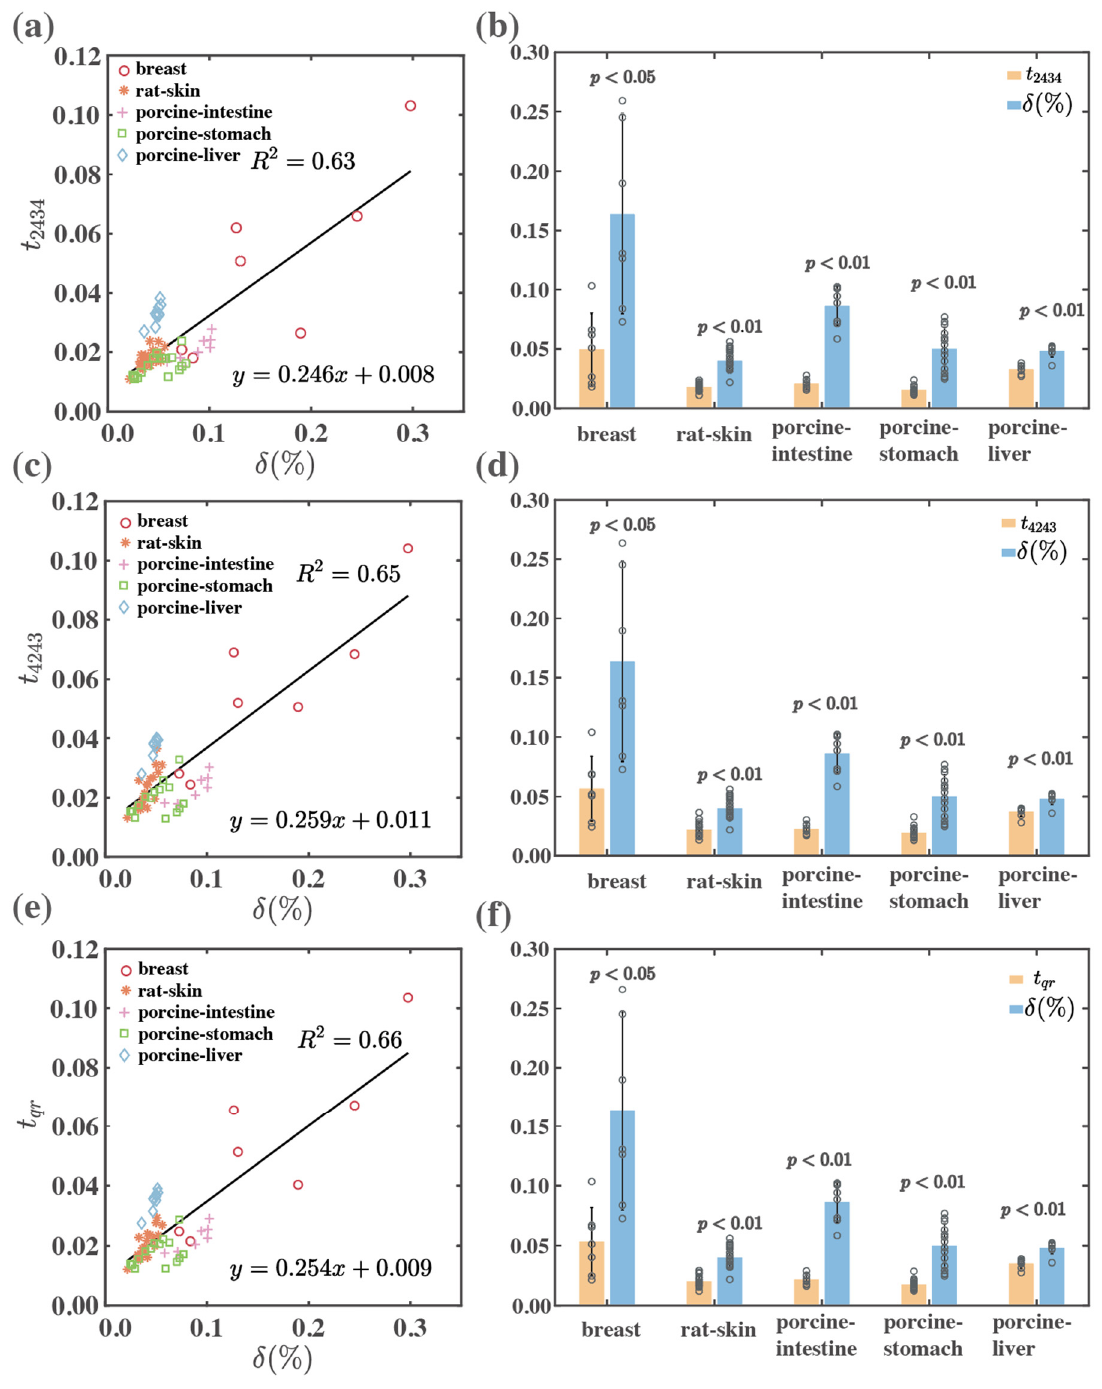
Figure 4. Comparison of MMT and MMPD linear retardance parameters of bulk tissue samples. ( a ) Linear retardance MMPD parameter δ plotted against its counterpart MMT parameter t 2434 for correlation analysis with all five kinds of bulk tissue samples. ( b ) Statistical analysis bar chart of linear retardance related MMPD parameter δ and MMT parameter t 2434 for each kind of bulk tissue samples. ( c ) Linear retardance MMPD parameter δ plotted against its counterpart MMT parameter t 4243 for correlation analysis with all five kinds of bulk tissue samples. ( d ) Statistical analysis bar chart of linear retardance MMPD parameter δ and MMT parameter t 4243 for each kind of bulk tissue samples. ( e ) Linear retardance MMPD parameter δ plotted against its counterpart MMT parameter t qr for correlation analysis with all five kinds of bulk tissue samples. ( f ) Statistical analysis bar chart of linear retardance MMPD parameter δ and MMT parameter t qr for each kind of bulk tissue sample.